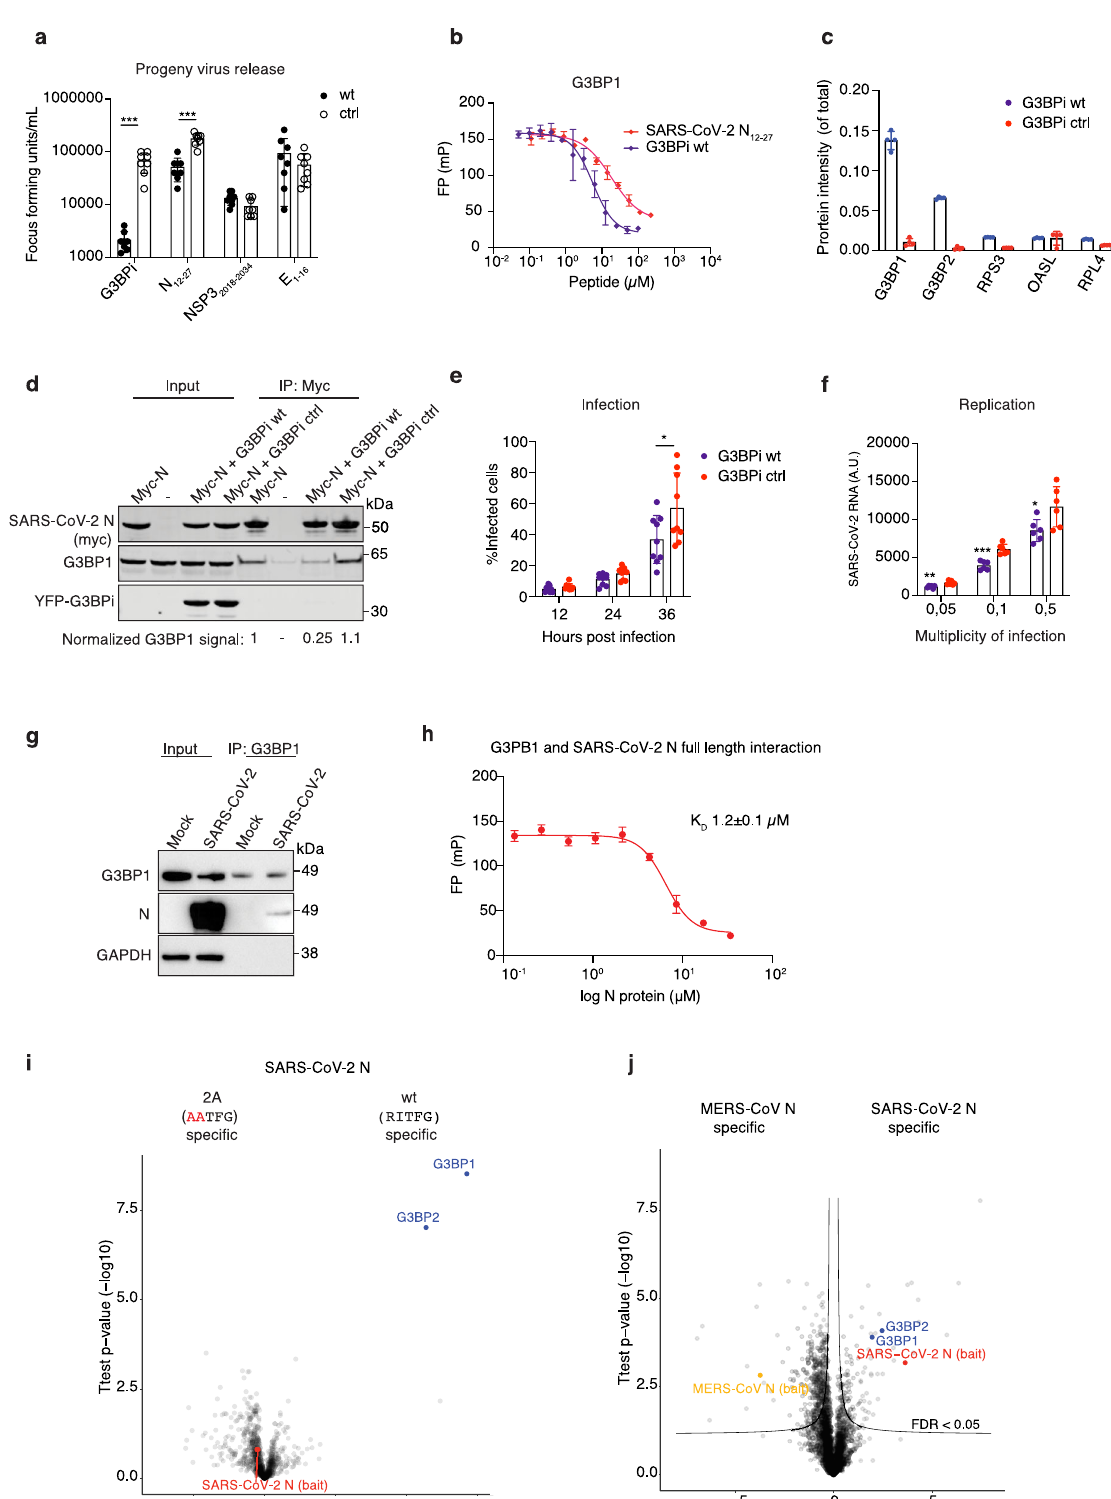
three copies of wild type (wt) or mutated (ctrl) SFV nsP3 SLiMs to GFP. As expected, mass spectrometry analysis con fi rmed that the major cellular targets of the G3BPi are the G3BPs (Fig. 2c, Supplementary Fig. 3b and Supplementary Data 4). Furthermore, expression of the G3BPi wt but not G3BPi ctrl prevented the binding of SARS-CoV-2 N to G3BP1 in cells (Fig. 2d). Consistent with these binding and competition data, lentiviral